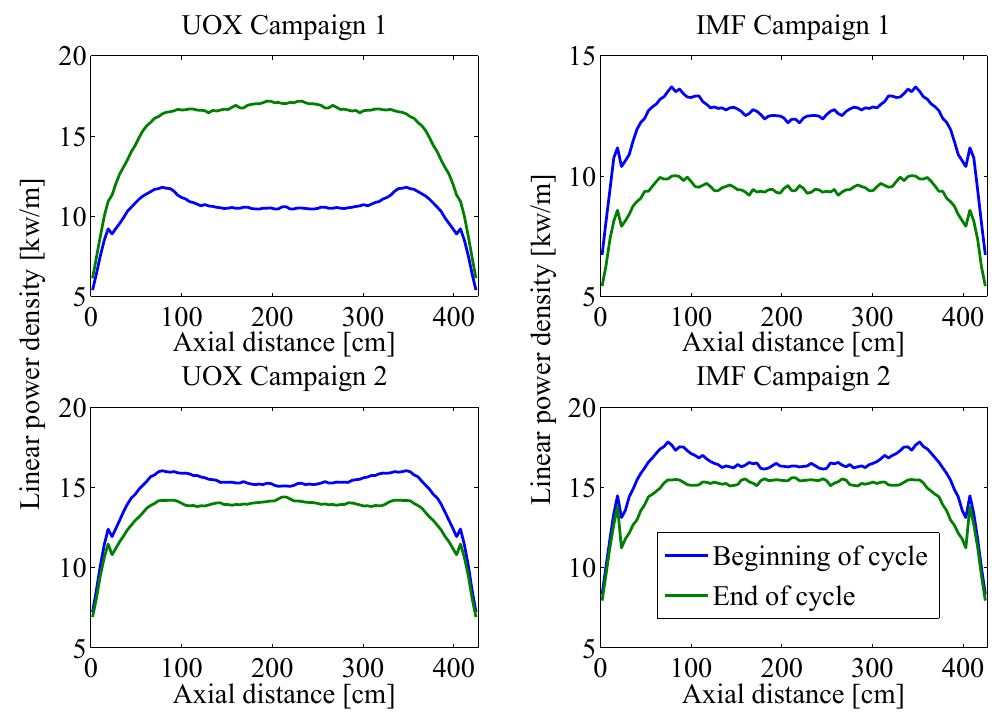
Figure 7. Axial power profile. The linear power of the hottest 4 assemblies are shown at the beginning and end of cycle.